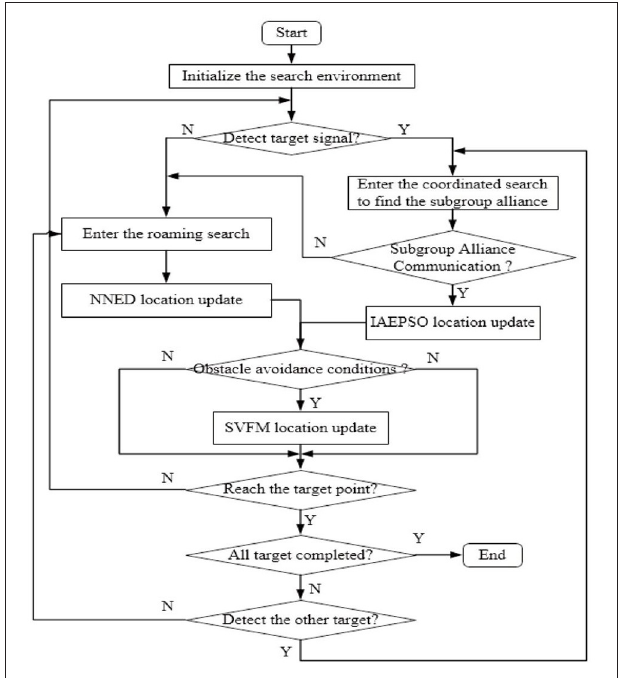
FIGURE 4 | MSRCPC algorithm flow diagram. TABLE 2 | The table of MSRCPC algorithm